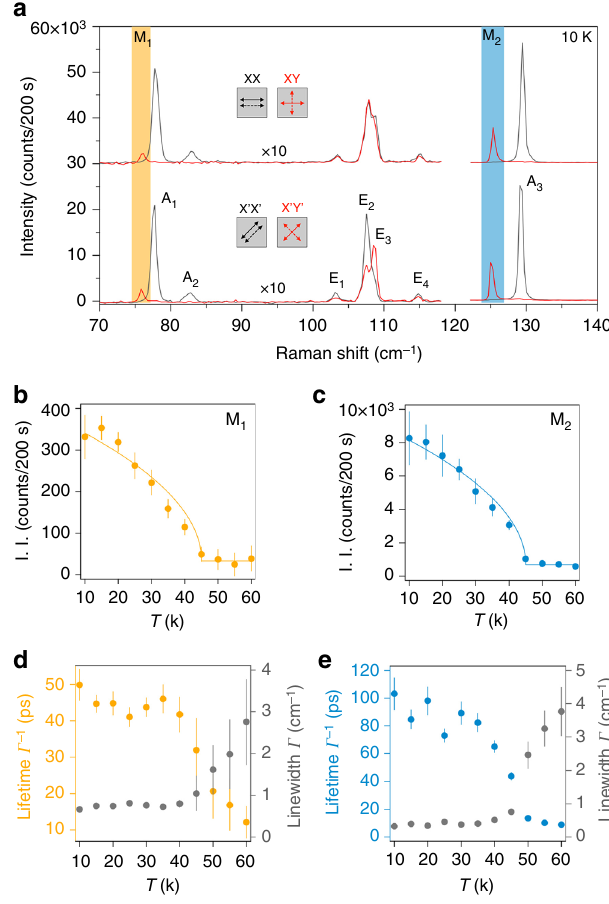
Fig. 2 Detection of the zero-momentum magnons in thick CrI 3 . a Raman spectra of a thick CrI 3 fl ake (13 layers) at low temperature (10K) in the parallel and cross-channels at ϕ = 0 o (XX and XY) and at ϕ = 45 o (X ’ X ’ and X ’ Y ’ ). Magnon modes, M 1 and M 2 , appearing only in the cross-channels (XY and X ’ Y ’ ), are highlighted in yellow and blue. Phonon modes are labeled as A 1 , A 2 , E 1 – E 4 , and A 3 . The spectral intensities in the 70 – 120cm – 1 range are multiplied by a factor of 10. The spectra in the XX and XY channels are vertically offset for clarity. The spectra are acquired using a 633-nm excitation laser. b , c Temperature dependence of I. I. of the M 1 and M 2 magnon modes, respectively. Solid curves are fi ts to I 0 þ I d , e Temperature dependence of the lifetime ( Γ − 1 , left axis) and the linewidth ( Γ , right axis) of the M 1 and M 2 magnon modes, respectively.